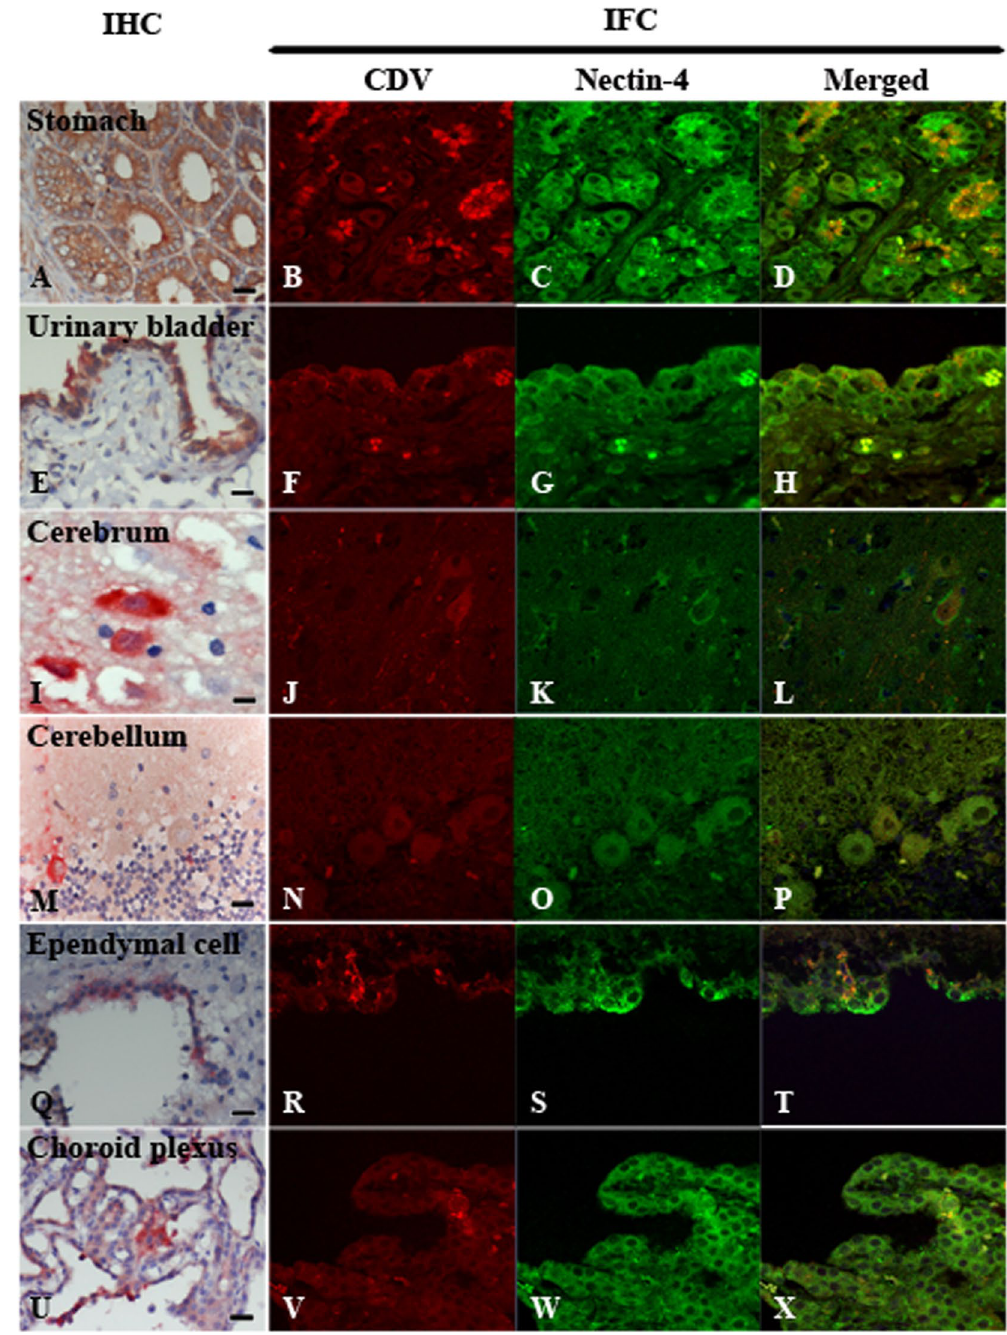
Figure 3. Immunohistochemistry (IHC) and immunofluorescence assay (IFA) of nectin-4 expression in canine distemper virus (CDV)-infected tissues. Nectin-4 was stained in brown (IHC) and in green (IFA) while CDV antigen was showed in red (IHC, IFA). Merged panel of IFA revealed the co-localization of both antigens in particular cells. Non-nervous tissues including gastric glandular epithelial cells of stomach ( A ; data of case No. 2) and transitional epithelial cells of urinary bladder ( E ; data of case No. 6) were strongly positive for nectin-4 and CDV antigens. The visualization of co-expression was augmented when IFA was performed ( B – D , F – H ). In nervous tissues, neurons in cerebrum ( I – L ; data of case No. 10), Purkinje’s cells in cerebellum ( M – P ; data of case No. 13), ependymal cells ( Q – T ; data of case No. 11) and epithelial cells of choroid plexus ( U – X ; data of case No. 6) showed the co-expression of both antigens. (IHC, Bar = 20 μ m; IFA, 4,000 fold